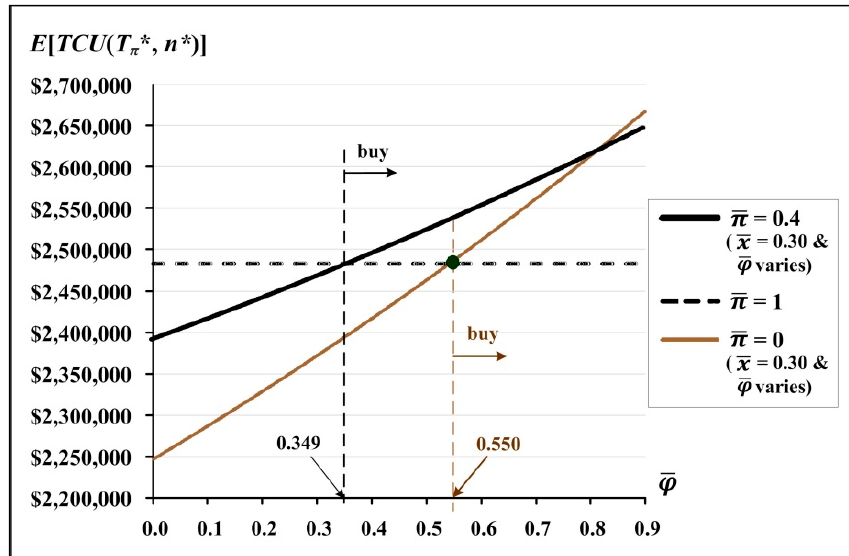
Figure 12. Impact of changes in ϕ on E [ TCU ( T π *, n *)] for managerial decision makings.